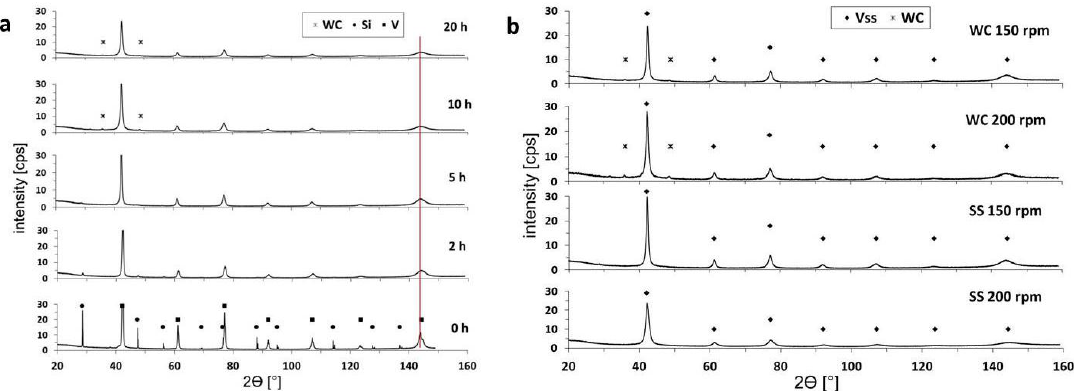
Figure 1. X-ray diffractograms of mechanically alloyed V-9Si-13B powders: ( a ) milling progress during the treatment with WC tools at 150 rpm and ( b ) effects of the type of grinding tools (WC-tungsten carbide; SS-stainless steel) and the rotational speed on the milling progress after 20